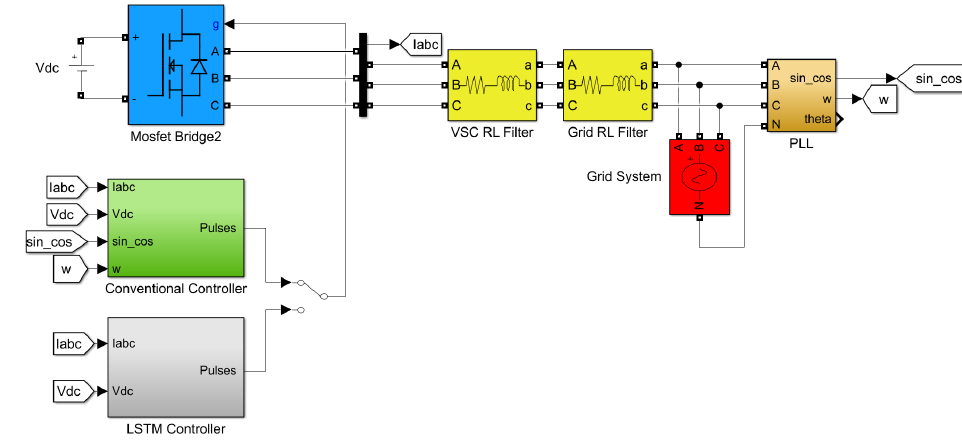
Figure 7. Simulink model of three-phase grid-connected VSC. − 1.09 pu to 0.23 pu at t = 1 s in Figure 8b. The LSTM has a settling i q , ref changes from